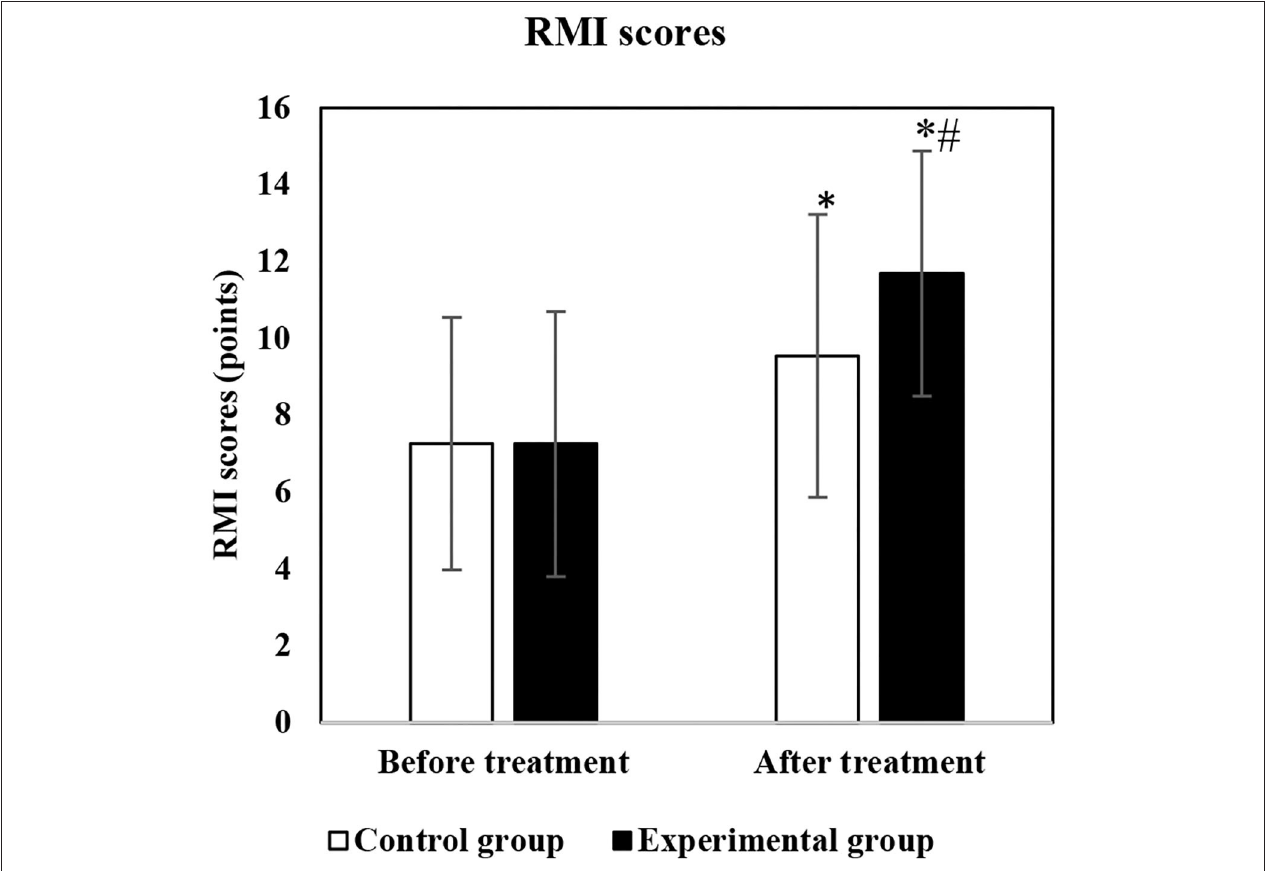
FIGURE 12 | Comparison of RMI scores before and after treatment. * and # indicated the statistically significant difference compared with the score before treatment and that of the control group, respectively ( p <